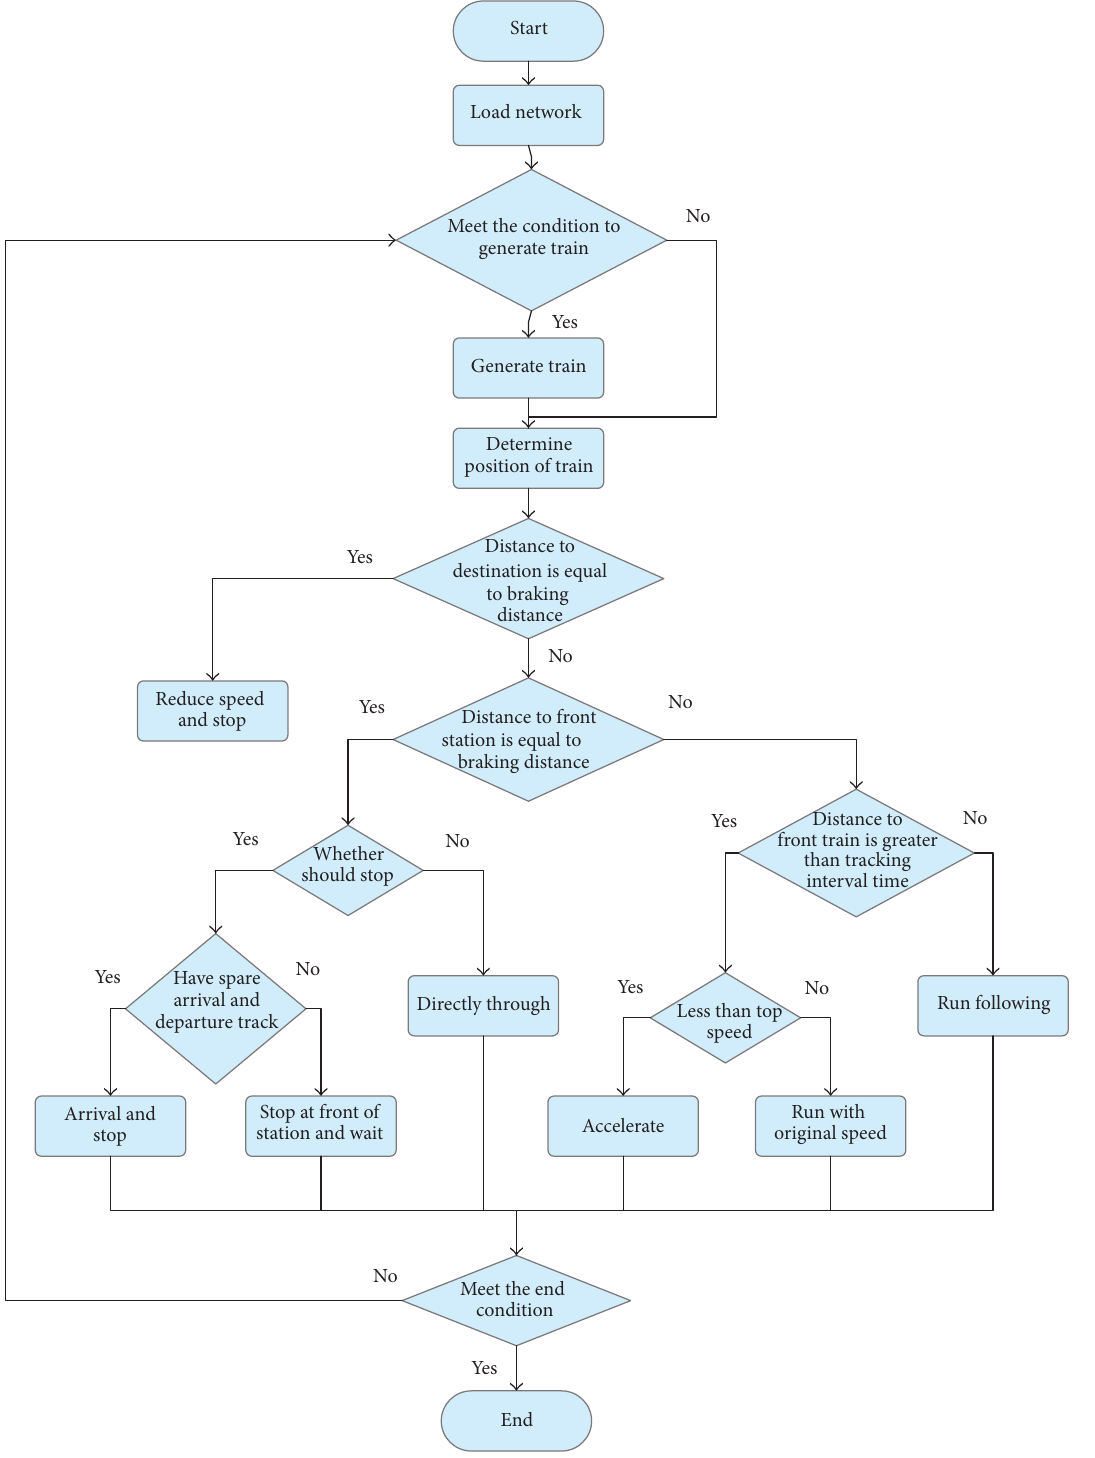
Figure 4: Simulation